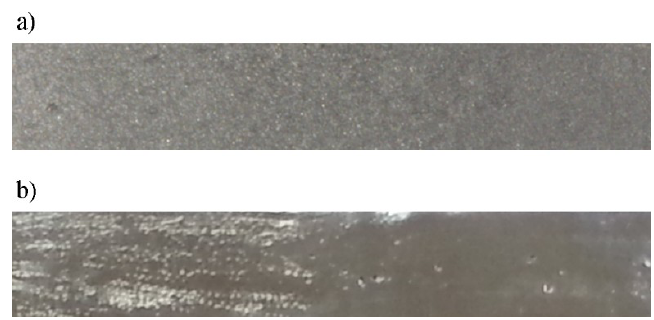
Figure 3. Cast specimen: ( a ) before polishing; ( b ) after polishing.